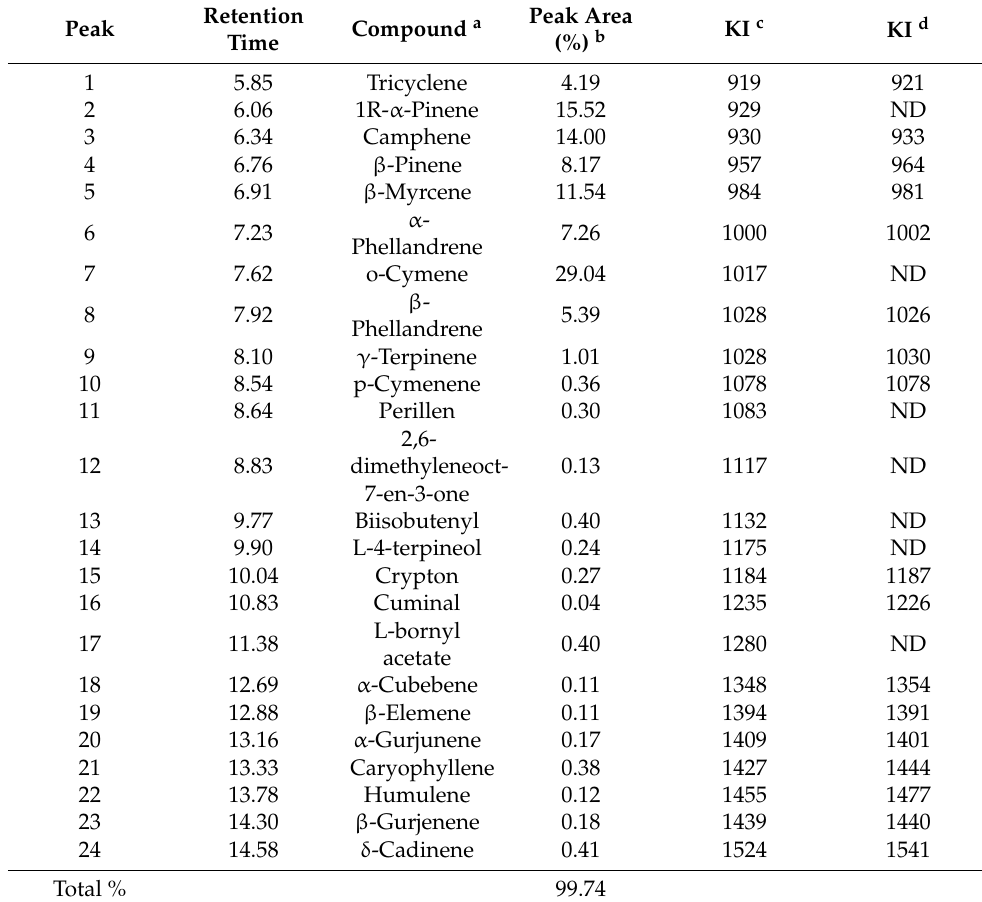
Table 1. Compounds obtained from Schinus molle leaves essential oil analyzed by